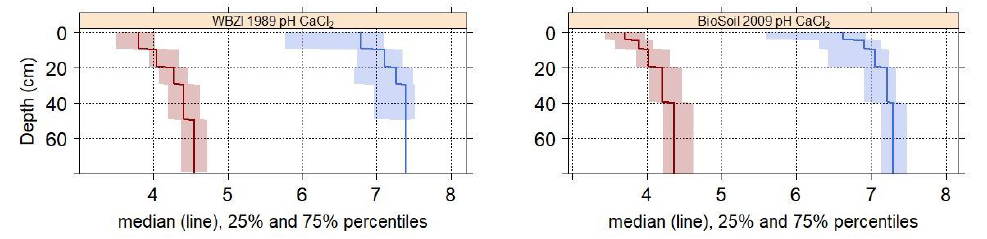
Figure 3. Extent of change in soil acidity over 20 years. Depth gradient of the median and the 25 and 75 percentiles of the pH in the mineral soil. Red lines and shades represent sites on silicatic bedrock, blue lines and shades represent sites on calcareous bedrock. Left graph: Forest soil survey in year 1989; right graph: BioSoil survey in year